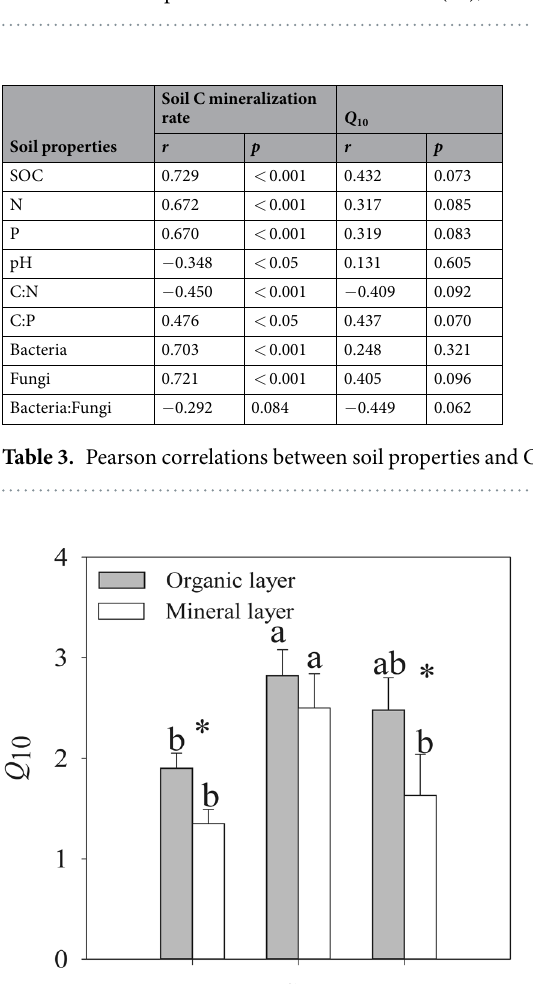
Table 2. Results of four factors ANOVA showing the F and P values for responses of soil C mineralization rate and cumulative C production to incubation time (IT), forest type (FT), temperature (T) and soil layers (SL).